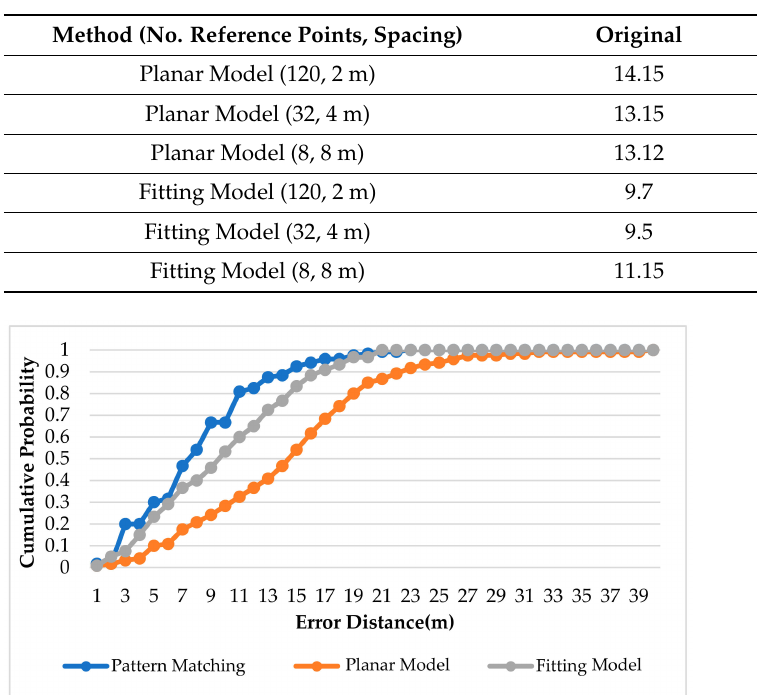
Table 10. Average Positioning Error Distance for Different Number of Reference Points.